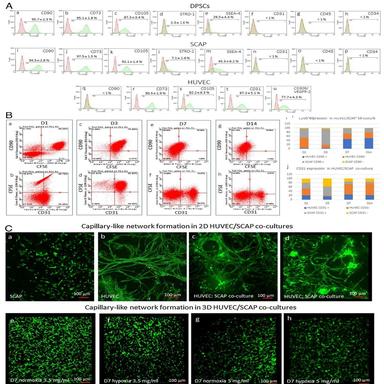
A: Immunophenotypic characterization of DPSCs (a–h), SCAP (i–p) and HUVEC (q–u) cells by flow cytometry. Representative single-parameter diagrams showing the expression of several mesenchymal (CD90, CD73, STRO-1), endothelial (CD105, CD31, CD309/VEGFR-2), hematopoietic (CD34, CD45) and embryonic (SSEA-4) stem (SC) markers (green line: unstained control, red line: marker of interest). Results are means (± SD) of three independent experiments. 2B: Immunophenotypic characterization of 2D HUVEC/SCAP co-culture